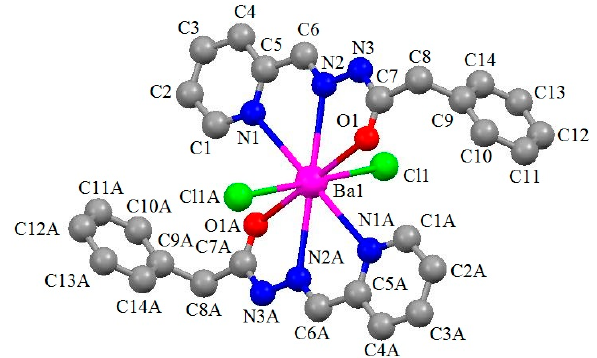
Crystals 2017 , 7 , 305 Figure 1. Coordination environment of Ba(II) ion in the complex. Figure 1. Coordination environment of Ba(II) ion in the complex.